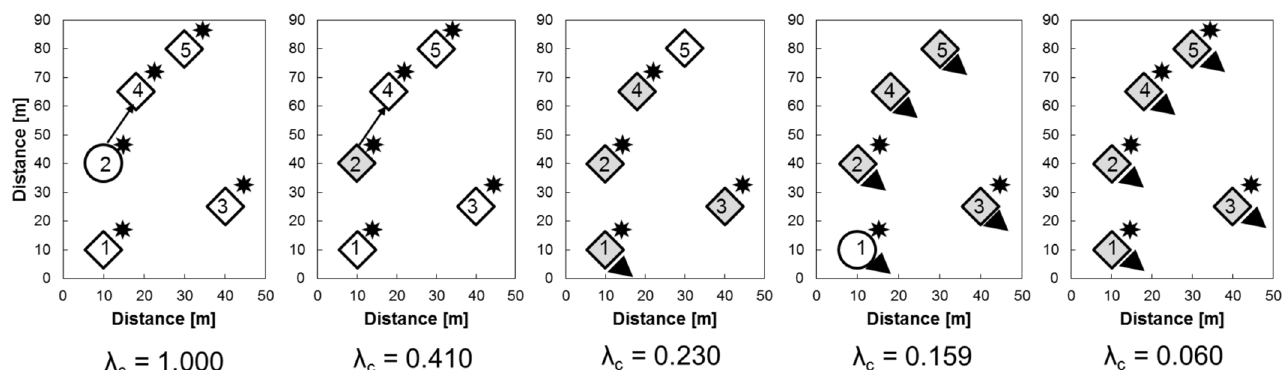
Fig. 3. Major design changes for unavailability-cost trade-off for several values of λ c and λ a , with λ e = 0. White diamonds, boiler and airco; white circle, available CHP for house and airco; grey diamond, available CHP for MG and airco; sun, PV; triangle, battery; black arrow, heating pipe; H, hot storage. All houses have a grid connection [3].